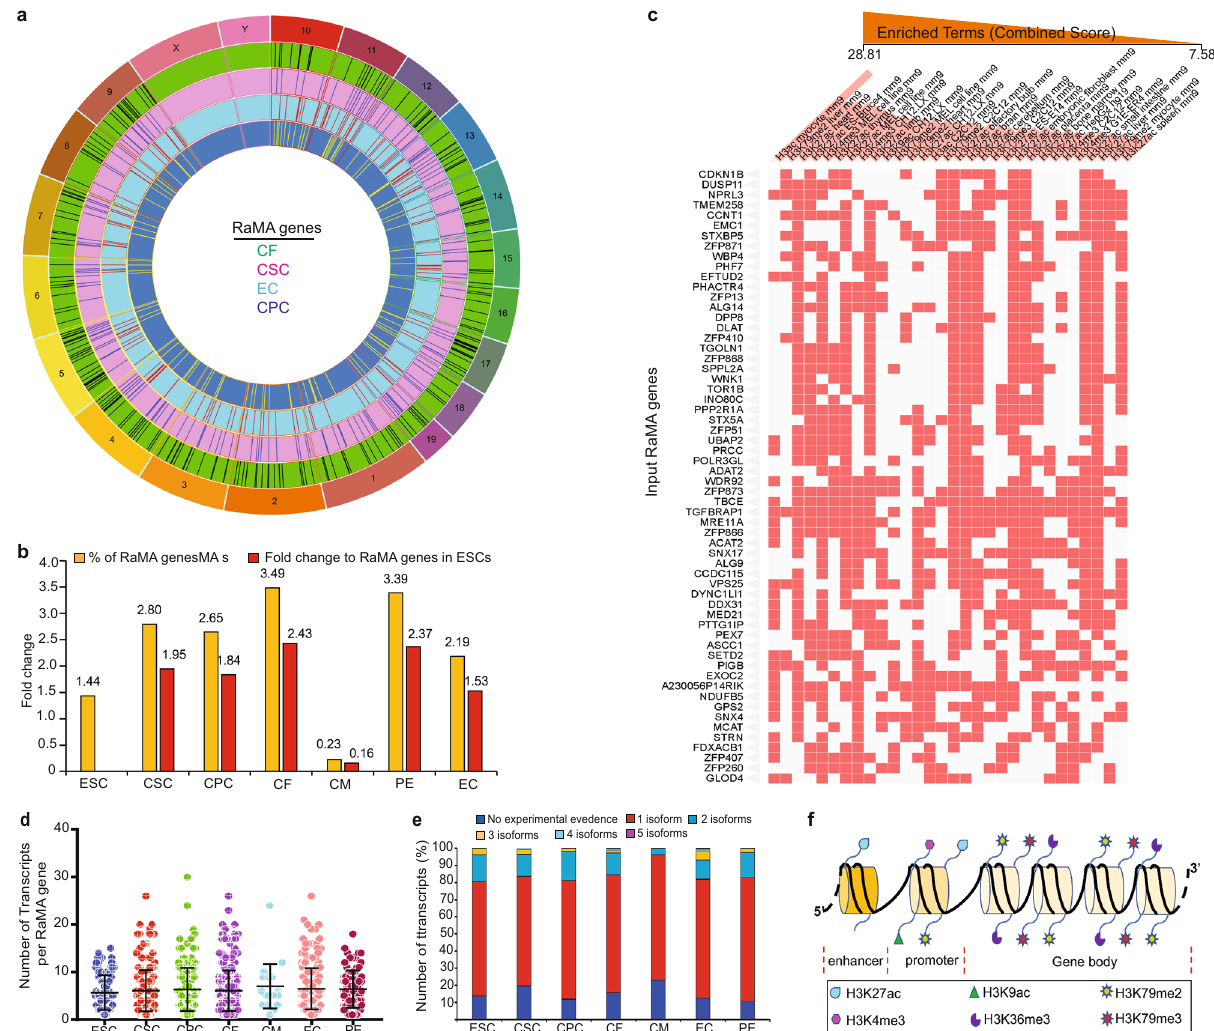
Fig. 3 | RaMA genes exhibit lineage speci fi city and expression is regulated by distinct histone modi fi cations to monoallelic genes. a Spatial arrangement of CSC, CPC, CF, and EC RaMA genes in the autosomes. Columns in each circle represent the gene positions. b Percentages and the fold changes of RaMA genes upon ESC differentiation (scRNA-seq). Percentages are calculated to non- monoallelicgenesandthefoldchangesarewithreferencetoRaMAgenenumberin mESCs. c HistonesignaturesofRaMAgenesfromsevencelltypes.Thirtytermsand 60RaMAgeneswiththehighestsigni fi cance(combinedscore)areshown.Enriched terms are columns (column order is the sum) and the input genes are the